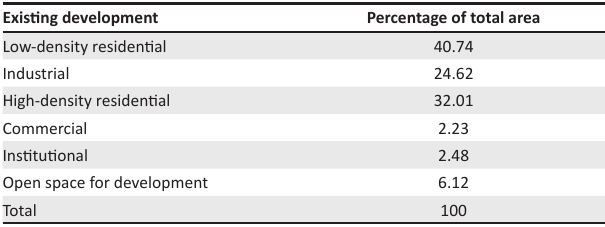
TABLE 1: Land use in Ruwa